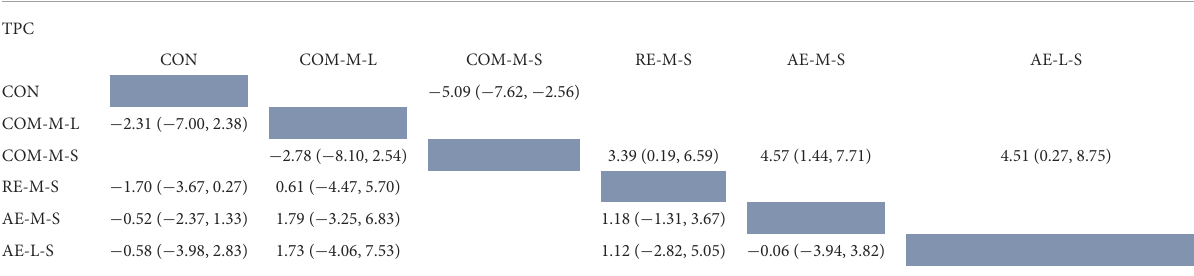
TABLE 4 Network meta-analysis matrix of results (TPC). Outcome Comparison of treatments: Mean difference (95% confidence intervals) effect of intervention in each row compared with intervention in each